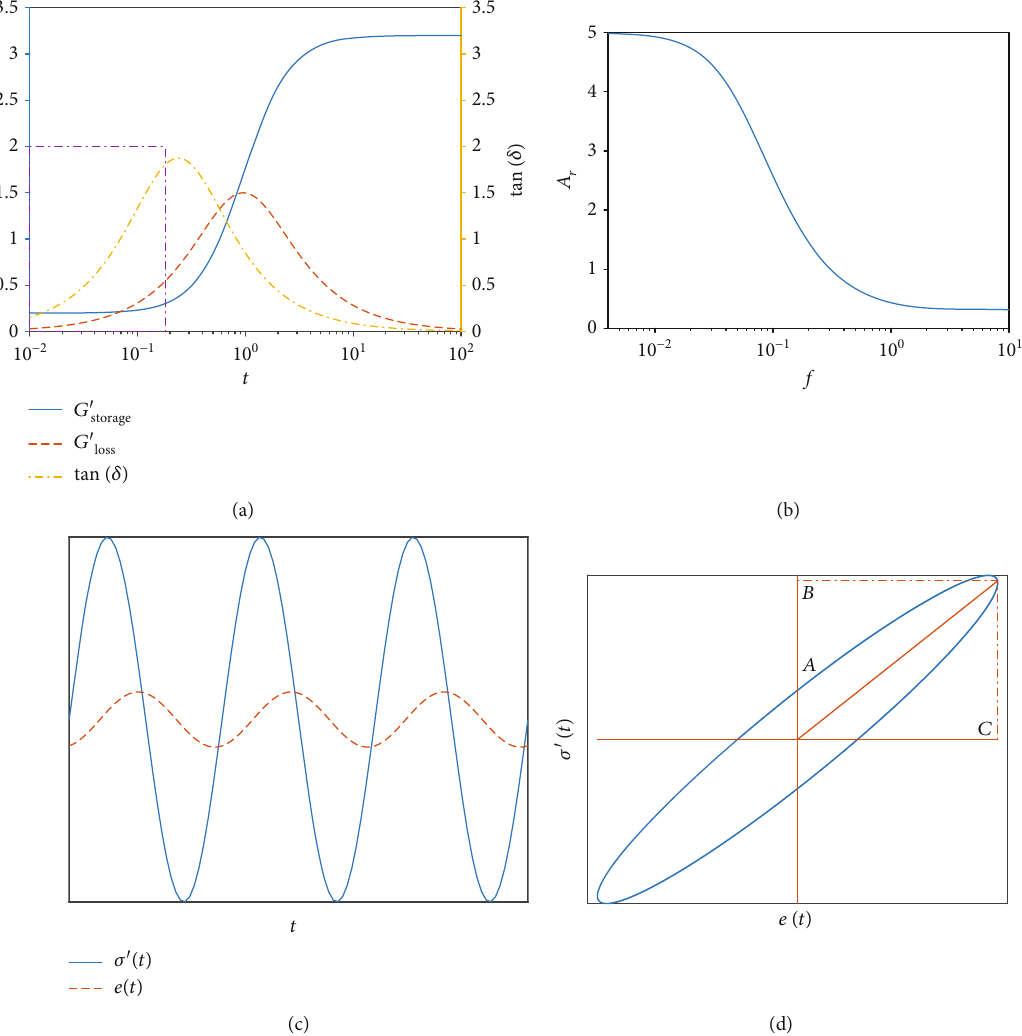
′ (solid line on y -axis), loss modulus G ′ storage loss ′ = 0 : 00075 , A ( y r